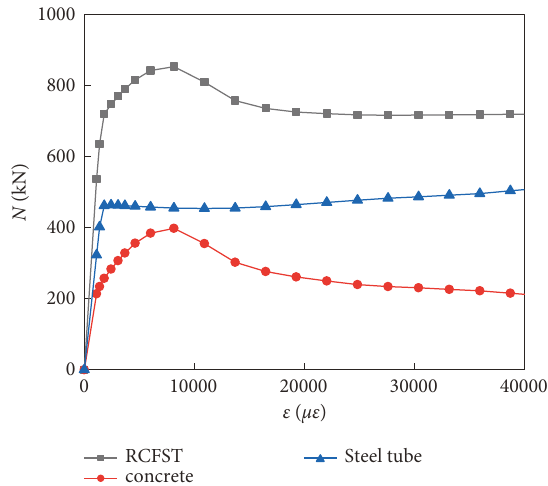
Figure 13: Load proportion diagram of components in RCFST.